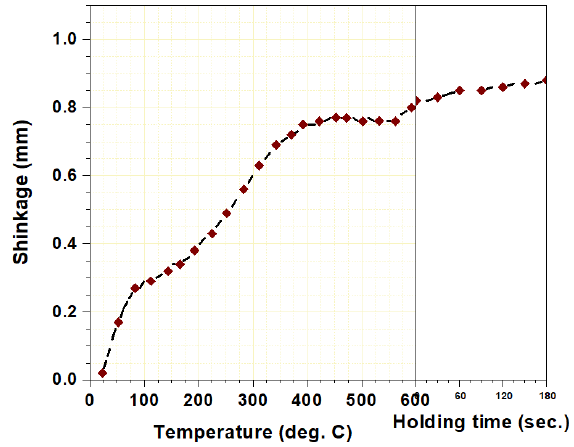
Figure 8. Shrinkage curve recorded during the SPS processing of Al 82 Fe 14 Ni 4 sample.